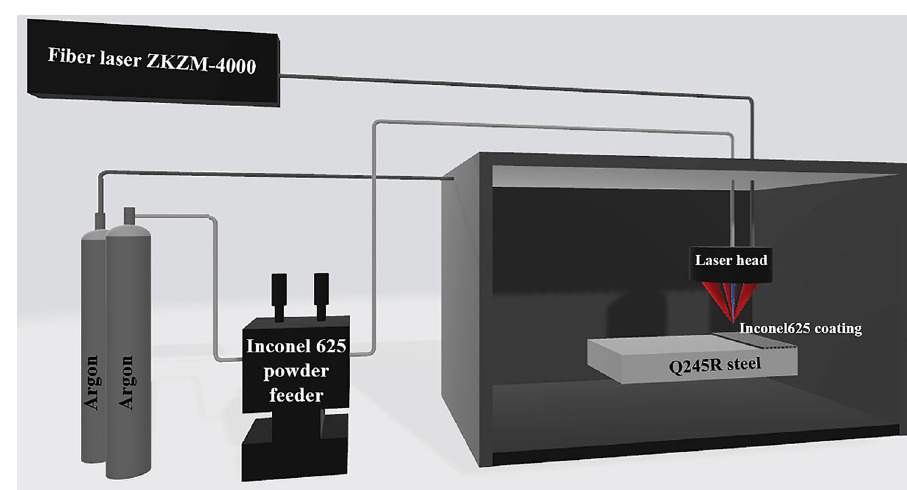
Fig. 11 Schematic diagrams of Inconel 625 superalloy deposited on the Q245R structure steel by high-speed laser cladding. Published in partnership with CSCP and